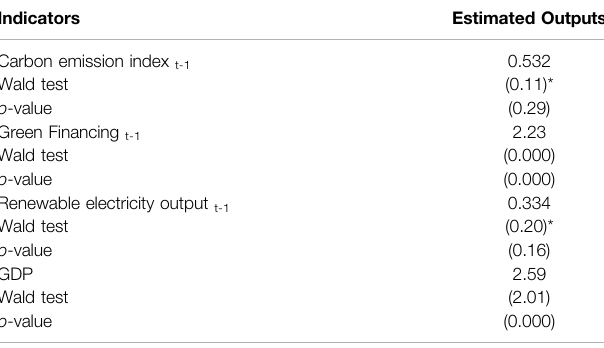
TABLE 5 | Quintile test for robustness analysis. Indicators